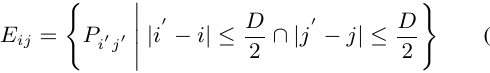
. when the duplicated lines D 2 , 2 − ( D +1) +1 4 2